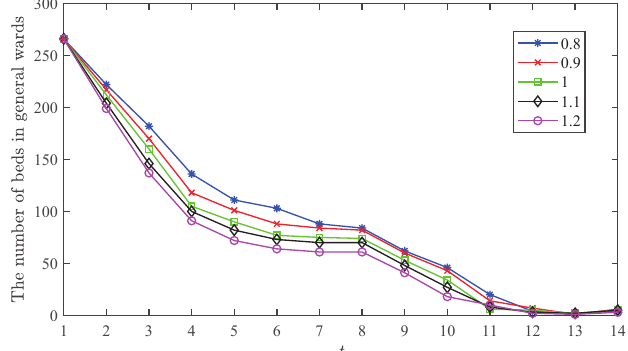
Figure 16. The number of beds in general wards in case 3.